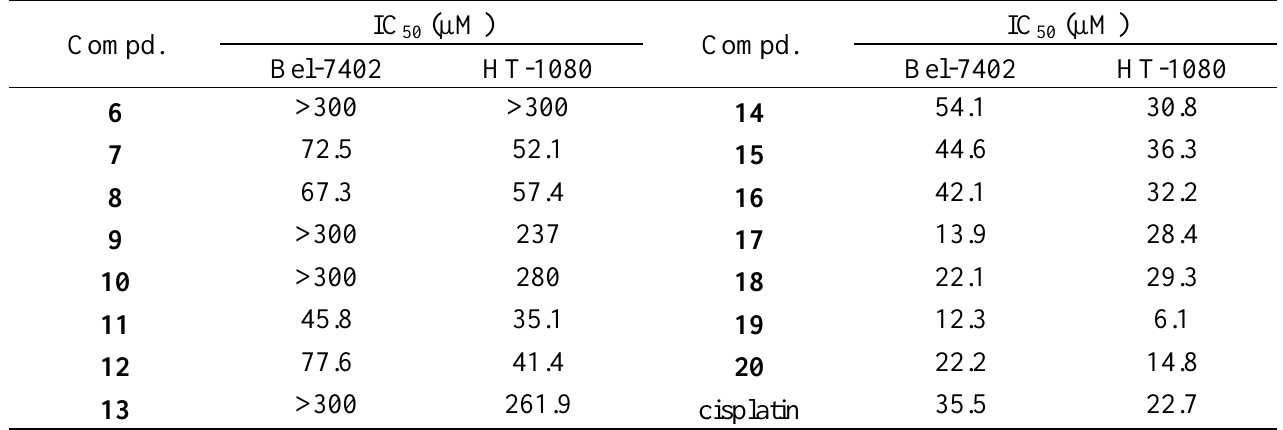
Table 1. The anticancer activities of compounds 6-20